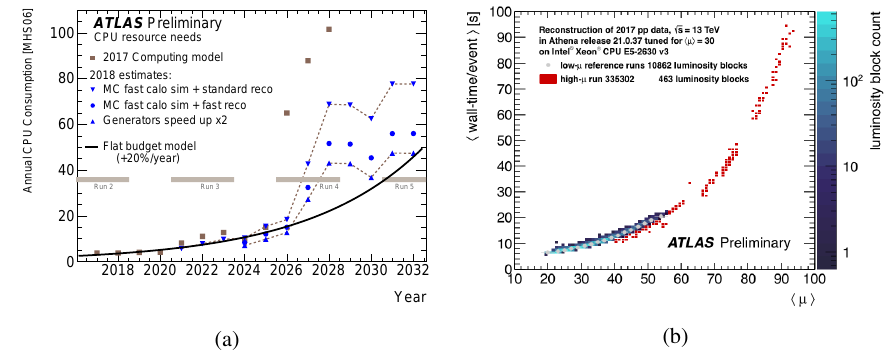
Figure 1: (a) Estimated CPU resources (b) Object reconstruction time as a function of pileup ( (cid:104) µ (cid:105) )